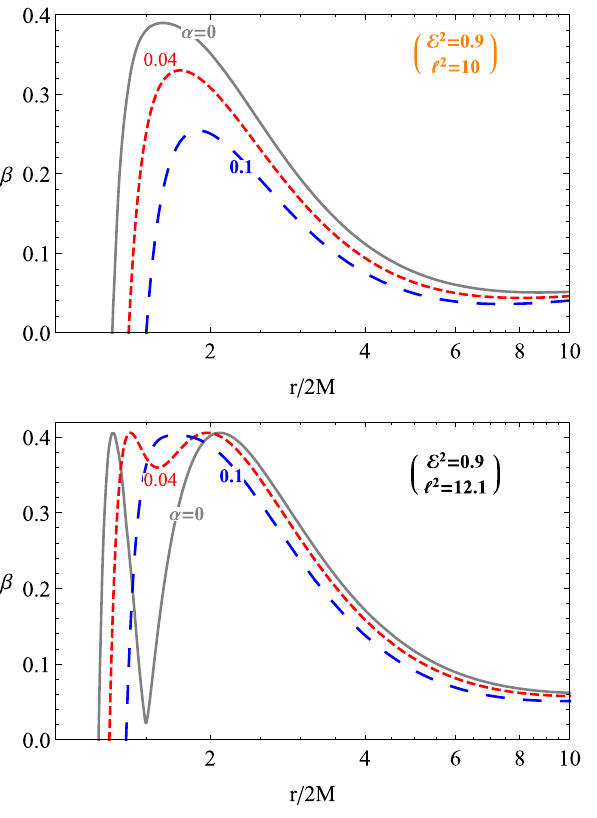
Fig. 1 The radial dependence of magnetic coupling parameter for the different values of α parameter. The plots are taken for the value of the √ √ Fig. 3 The radial dependence of minimal value of magnetic coupling specific energy E = 0 . 9 and angular momentum l = 5 (top panel) √ parameter of the magnetized particle for the different values of the α and l = 6 . 074 (bottom panel) parameter. The plots correpond to the values of the specific angular momentum l 2 =